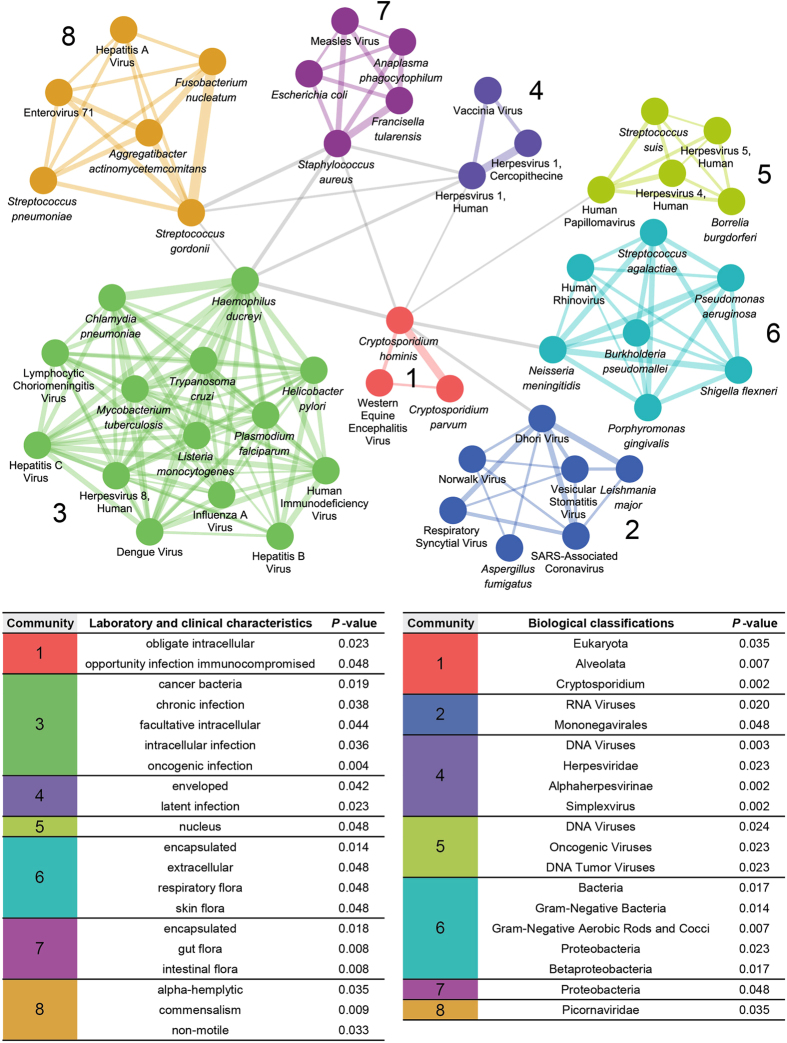
HTR communities.Each node represents a pathogen type. Pathogen pairs whose HTRs were significantly similar are connected with an edge, the thickness of which is proportional to the pair’s association score. A community is defined as a group of nodes that are closely interconnected with each other, with fewer connections to nodes outside the group. HTR communities were identified based on association scores and labeled numerically according to the alphabetical precedence of the exemplar pathogen. Enriched HTR-related biological classifications, along with laboratory and clinical characteristics, are summarized (detailed information in Supplementary Table S4).